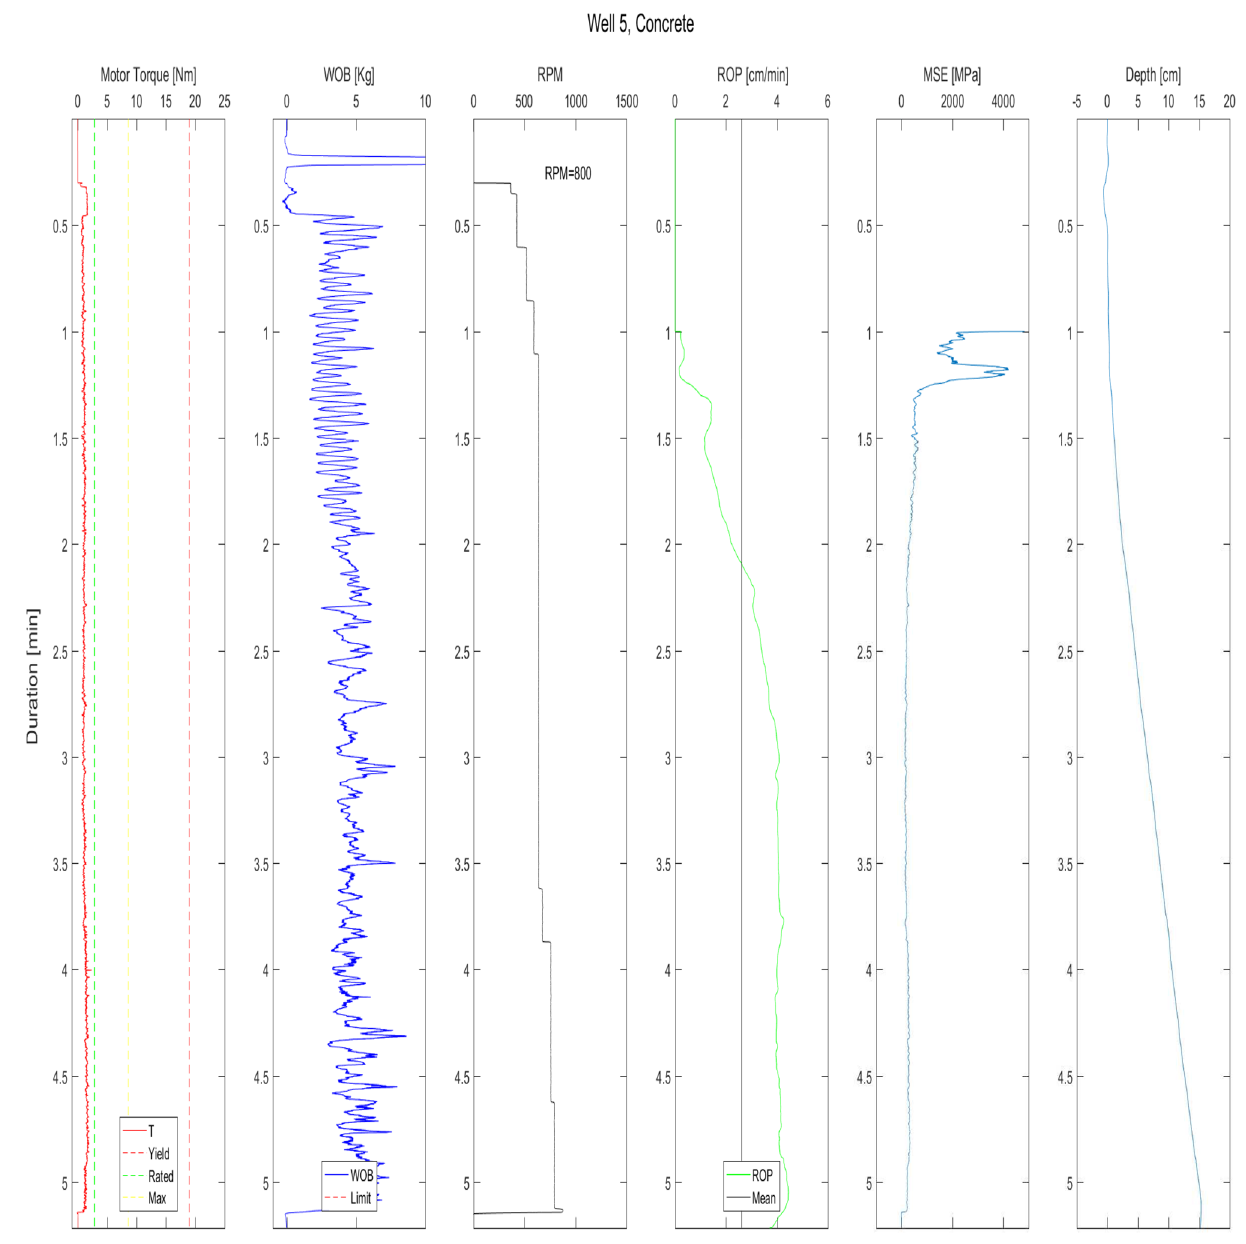
Fig. 14 Well Concrete 5, autonomous